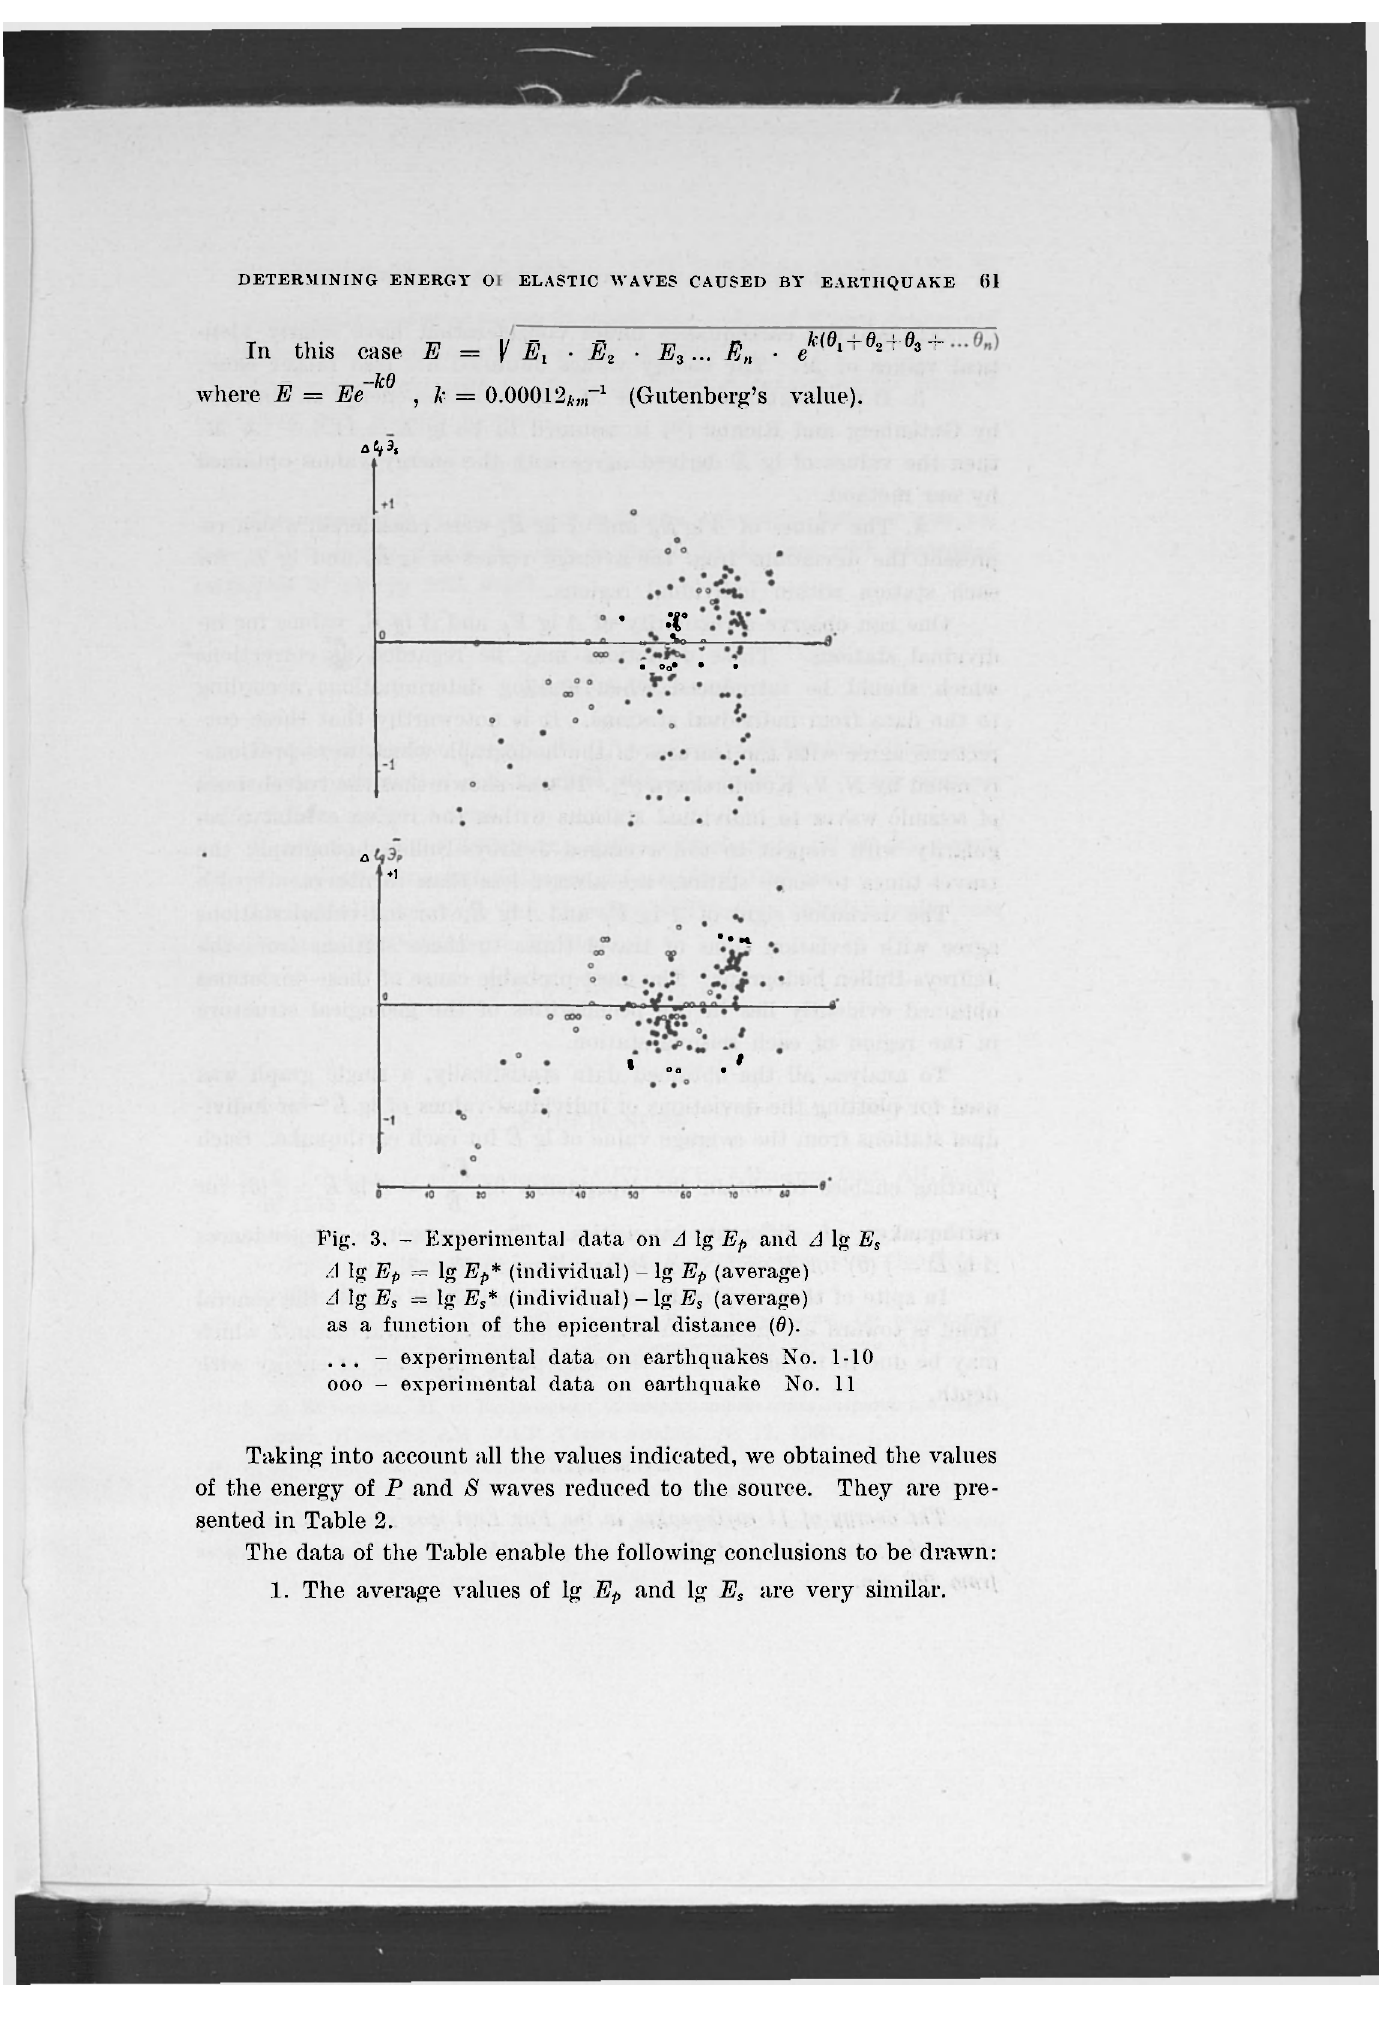
Fig. 3. - Experimental data on A lg Ep and A lg E s A lg Ep = lg Ep* (individual) - lg Ep (average) A ]g E s = lg E s * (individual) - lg E s (average) as a function of the epic.entral distance